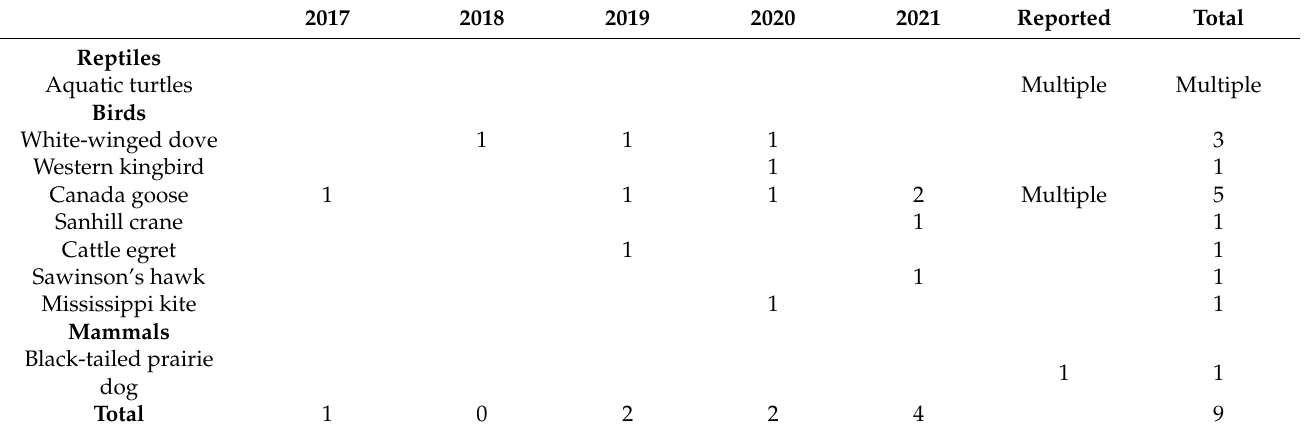
Table 1. Animals 1 brought or reported to the South Plains Wildlife Rehabilitation Center in Lubbock, Texas, after being shot and found in urban